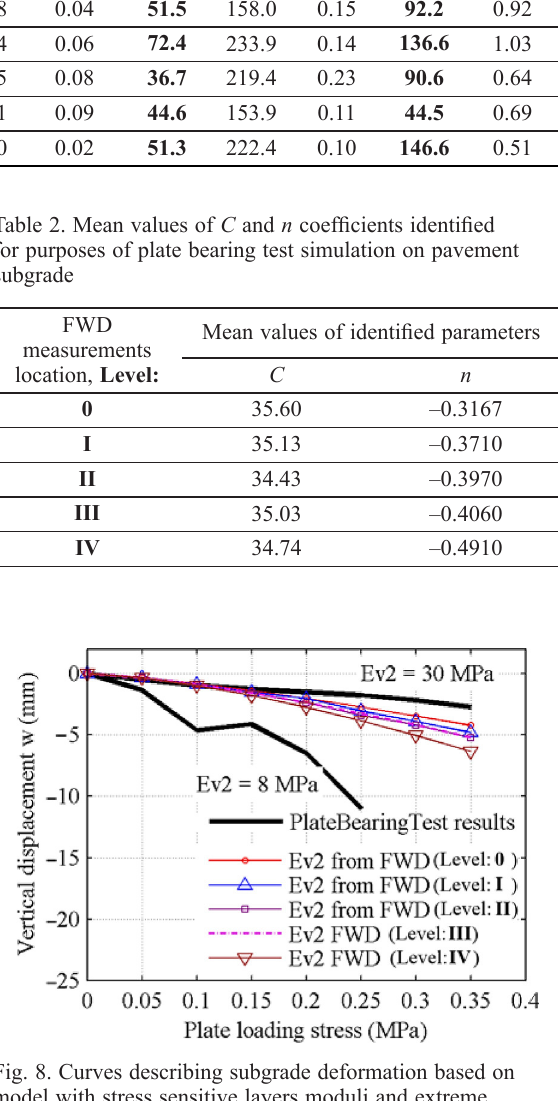
Fig. 7. Extreme plate bearing test results for pavement subgrade of the test section: 0+150.00÷0+395.00 km.